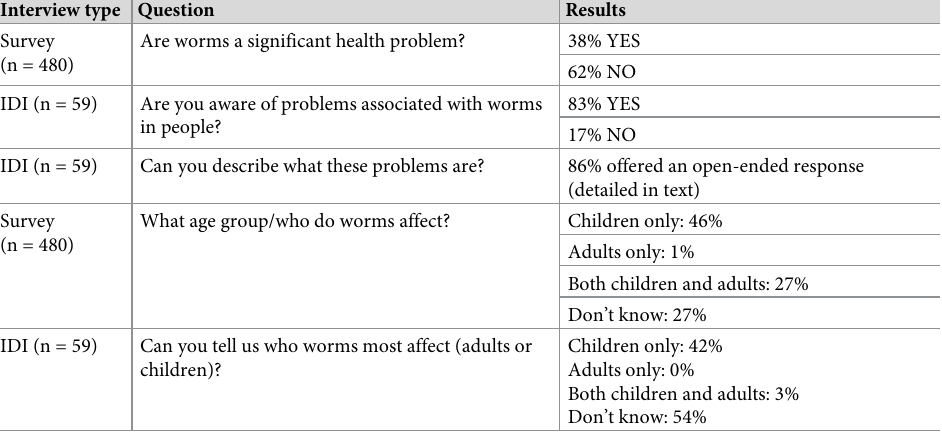
Table 1. Survey and IDI questions regarding the impact of STH and which age groups are affected. S1 and S2 Data. Interview type